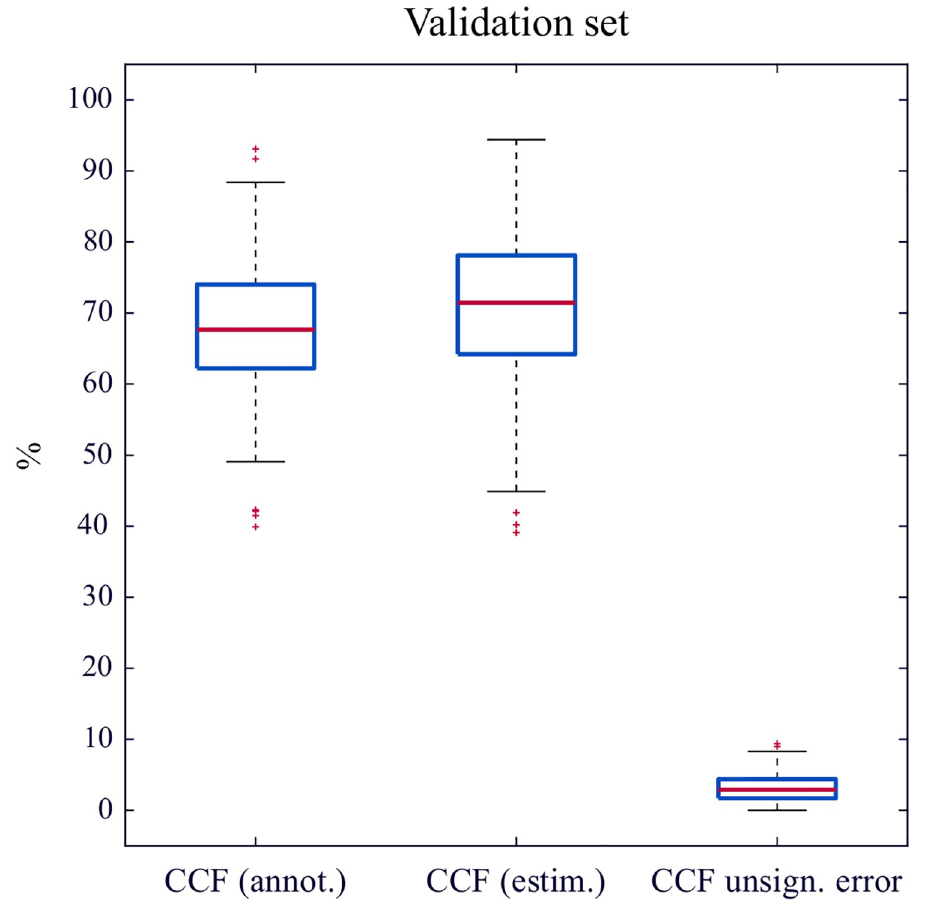
Fig 5. Computation of CCF in the validation subset. From left to right, distributions of the CCF computed from the annotations, estimated by the algorithm, and unsigned error in the estimation.